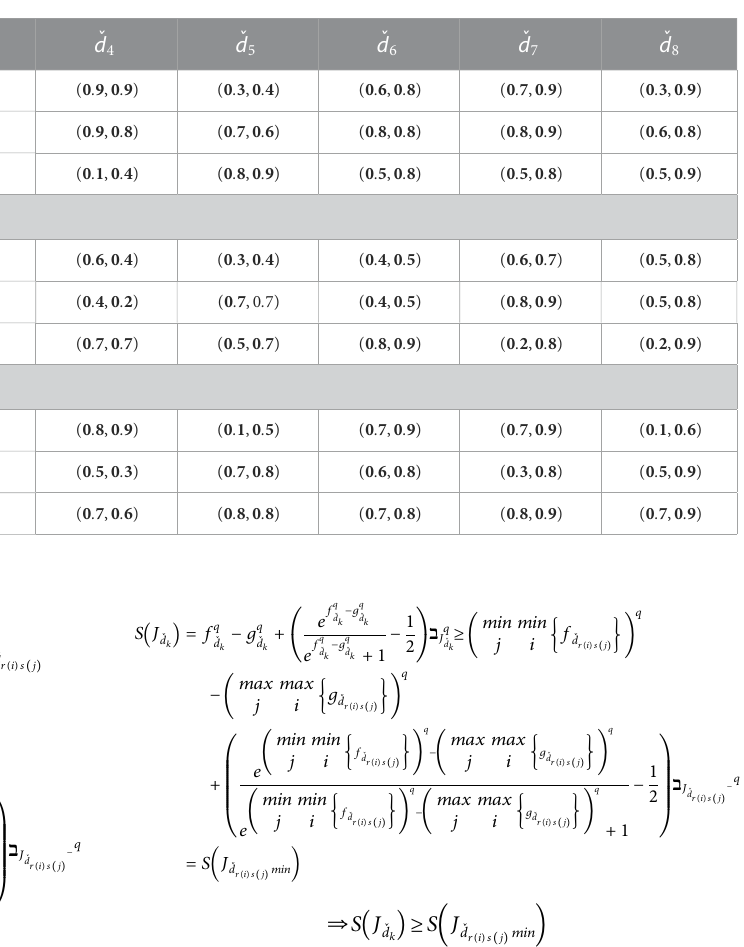
TABLE 2 Ordered decision matrix for